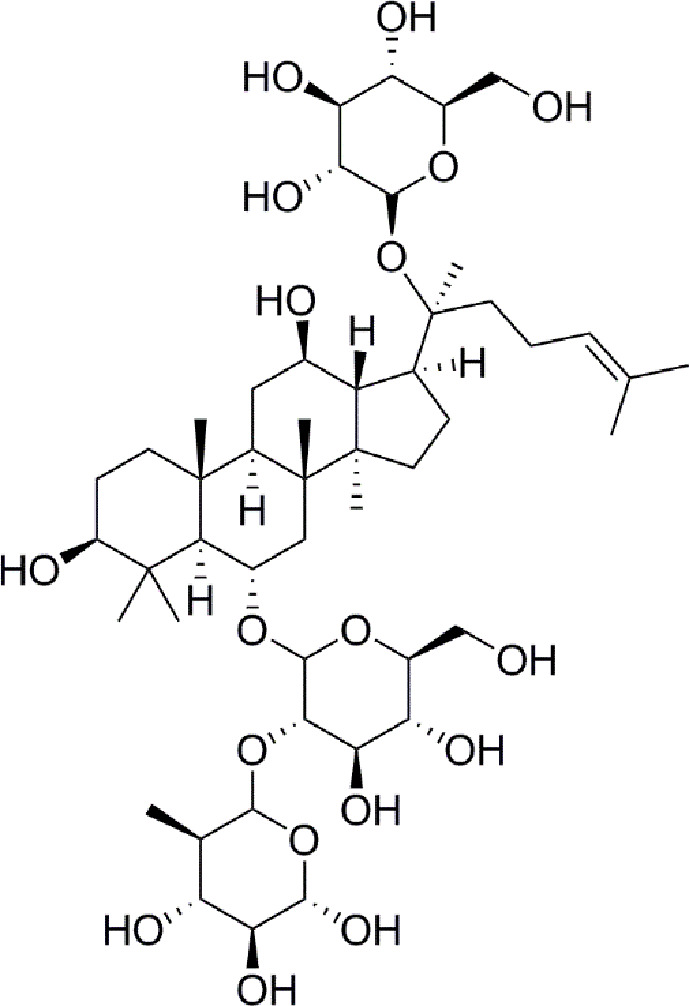
Chemical structure.